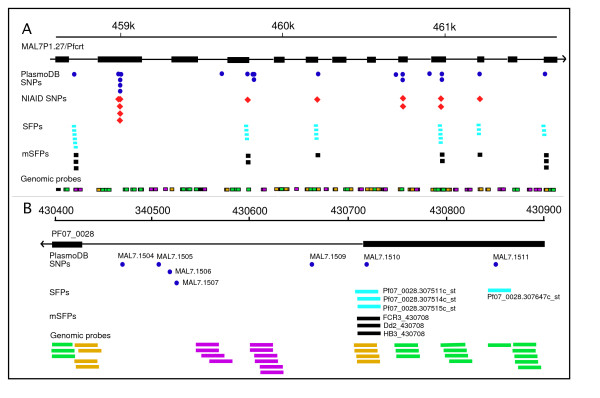
Genome browser displays (drawn in Canvas) showing SFP, mSFP and SNP from two genomic loci on chromosome 7.A. A genome browser window (~3 kb) showing expanded chromosome region covering pfcrt gene (top line) and predicted exons/introns of the pfcrt gene, SNP in PlasmoDB (blue circle), NIAID SNP (red diamonds), SFP from individual probe (light blue squares), mSFP (black squares) and all genomic probes covering the pfcrt gene. Color codes for the genomic probes are: green, probes in coding regions; purple, probes in noncoding regions; and yellow, probes spanning protein coding and noncoding regions. Note the mSFP matched well with those known SNP. B. An expanded region (500-bp window) from PF07_0028 showing distributions of PladmoDB SNP and array probe locations. Five of the seven PlasmoDB SNP (blue circle) in the intron were not covered by any probes. One SNP matched a mSFP call (black bars in multiple parasites), and another was covered by one probe and but was not called (filtered out because of single probe). The color codes for the genomic probes are the same as those in A; the labels are either SNP ID (blue circles) or probe ID (black and light blue bars).